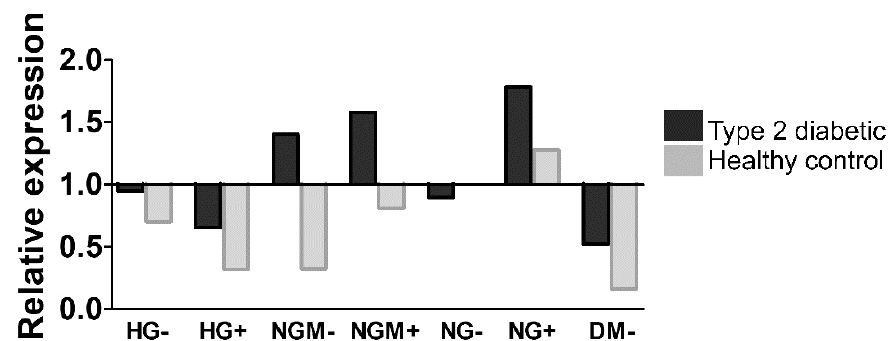
Figure 7. The preliminary assessment of glucokinase ( GCK ) gene expression in di ff erent glucose and insulin concentrations. Expression of GCK in type 2 diabetic (UTA.08002.DMs) or healthy control (UTA.10902.EURCCs) patient-derived hiPSC-RPEs (three technical replicates, one biological replicate) was studied when cultured in di ff erent glucose and insulin concentrations (see treatments and abbreviations below). Treatments and their abbreviations: High glucose (HG, 25mM), normal glucose 5 mM balanced with mannitol 19.5 mM (NGM), or normal glucose (NG, 5 mM) in the presence or absence (+/ − ) of added insulin. Each bar represents the medium of three technical replicates.